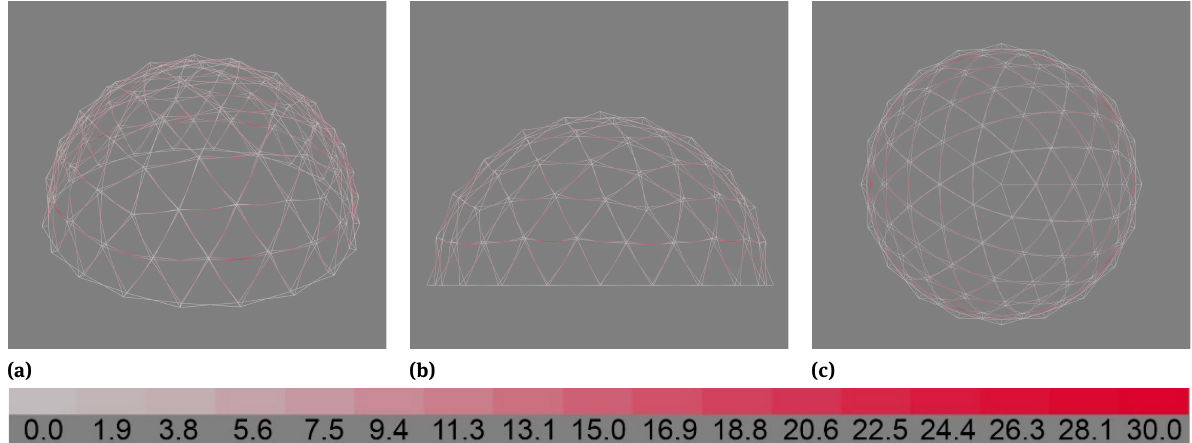
Figure 16: Pole structure under the snow load (1.5 kN/m 2 ). a) 3D view, b) Side view, c) Top view. Maximum displacement: 27.30